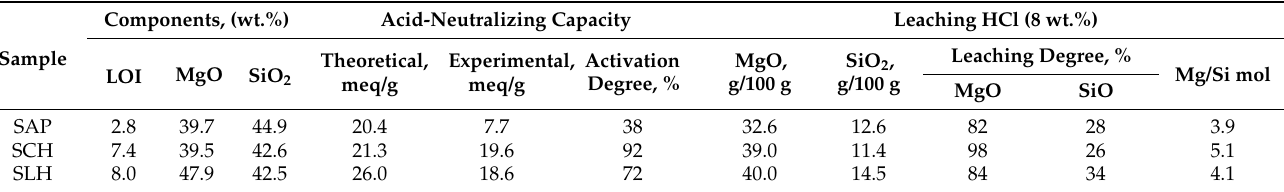
Table 4. The degree of serpentine